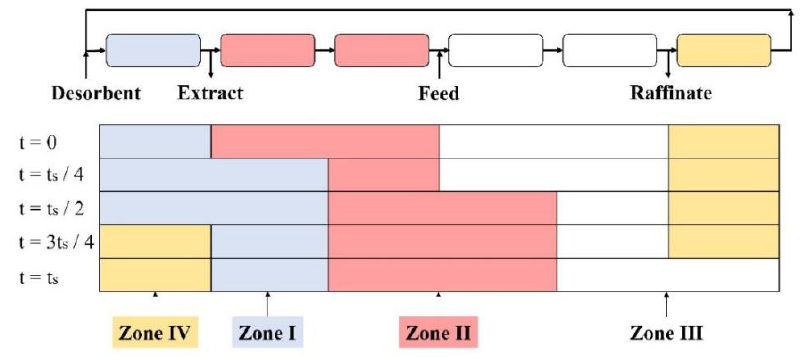
Figure 12. Schematic diagram of VariCol.